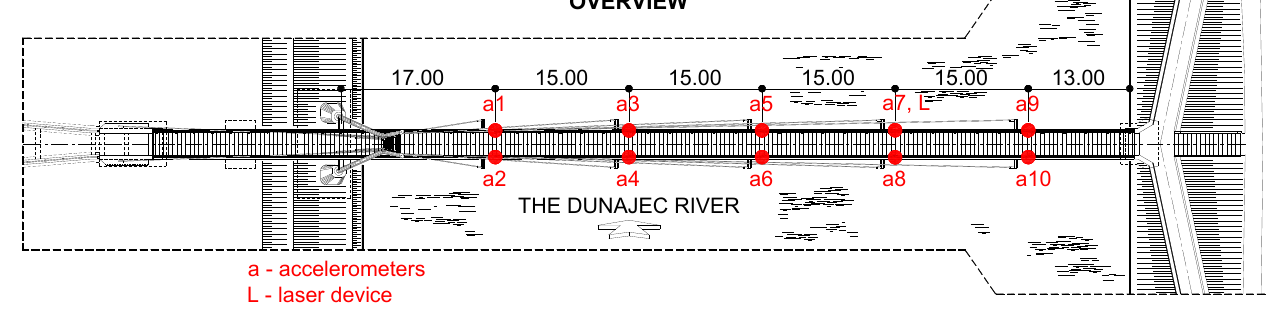
Figure 9. Location of measurement devices.